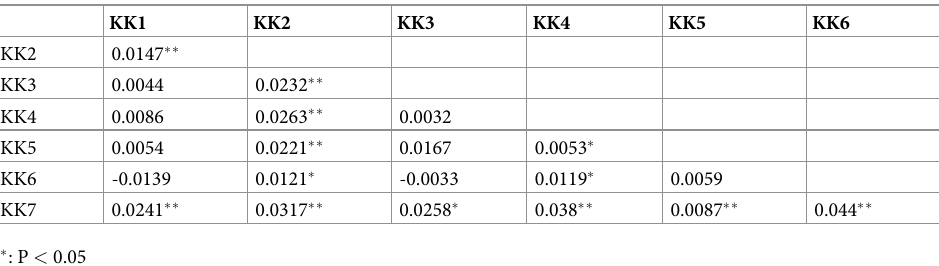
Table 3. Pairwise fixation index values (F st ) between seven Ae . albopictus populations in Kitakyushu. KK1 KK2 KK3